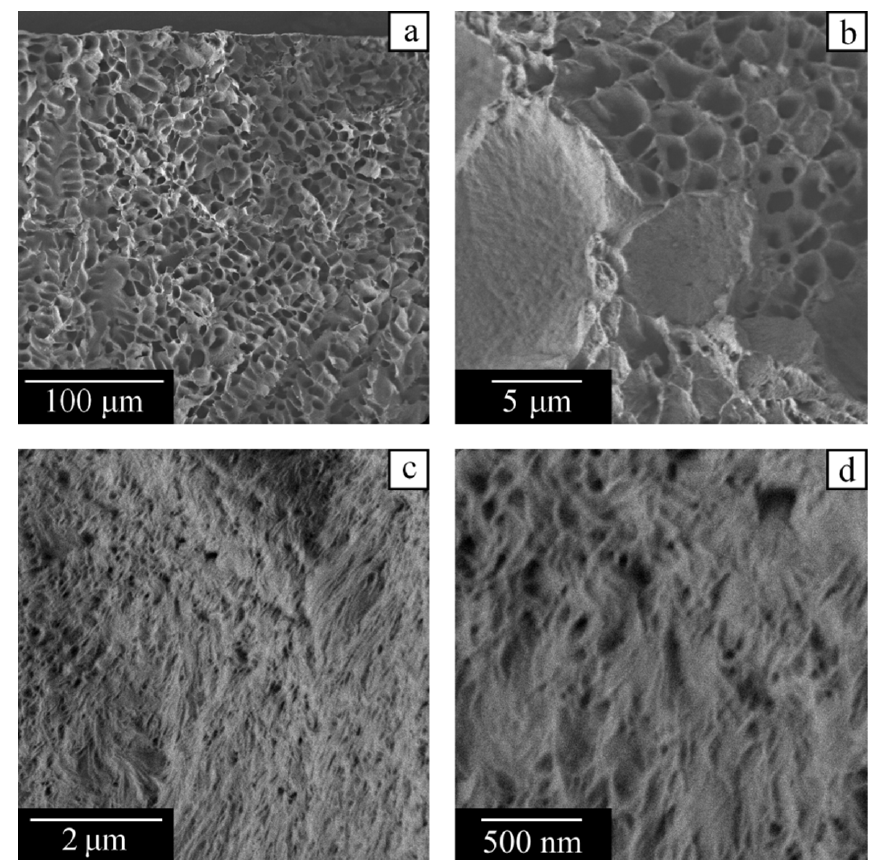
Figure 12. SEM images of the capillary-porous body obtained from the PVDF–camphor mixture containing 28 wt% of the polymer. Note the different scale bars in the images ( a − d ).